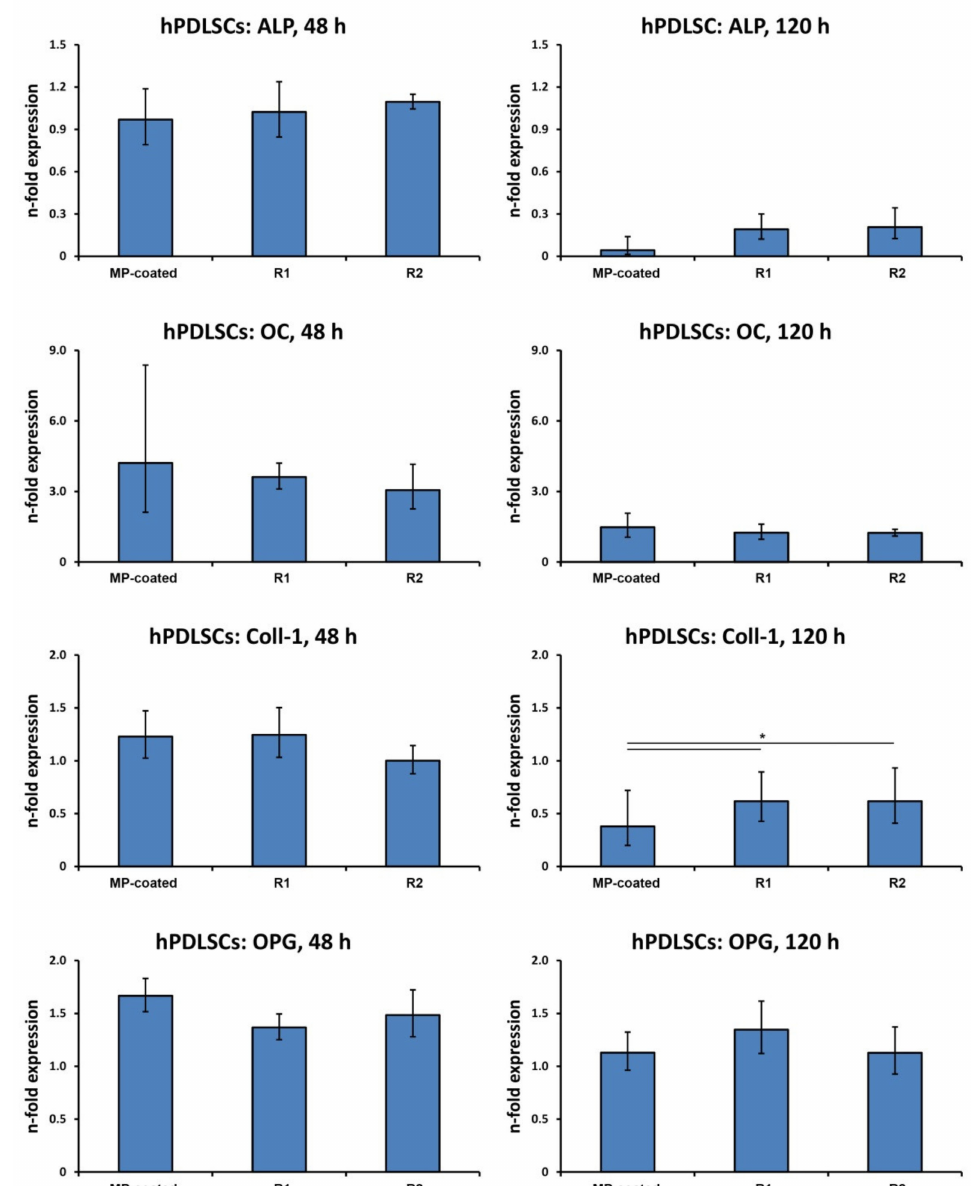
Figure 4. Expression of genes related to osteogenesis and bone turnover in hPDLSCs grown on titanium surfaces. hPDLSCs were cultured on multi-phosphonate (MP)-coated, sand-blasted, and acid-etched reference surfaces (R1, R2) and tissue culture plastic (TCP) for 48 and 120 h, and the expression of ALP, OC, Col1, OPG, and RANKL was assessed by quantitative real-time PCR. Y-axis represents n-fold expression related to hPDLSCs on TCP determined using the 2 − ∆∆ Ct method, using GAPDH as a housekeeping gene. Data are shown as the mean ± S.E.M of four experiments that were conducted independently. *—significantly di ff erent between groups, p <